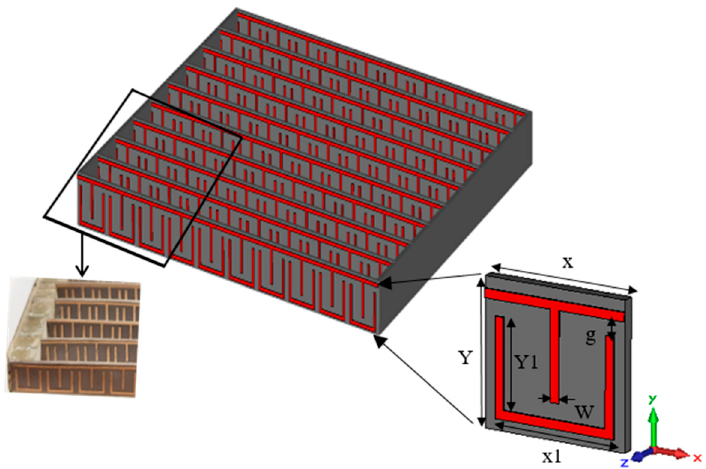
Figure 1. Schematic view of the contiguous squares resonator (CSR) periodic structure with the geometry of the single metamaterial (MM) unit cell and fabricated prototype.